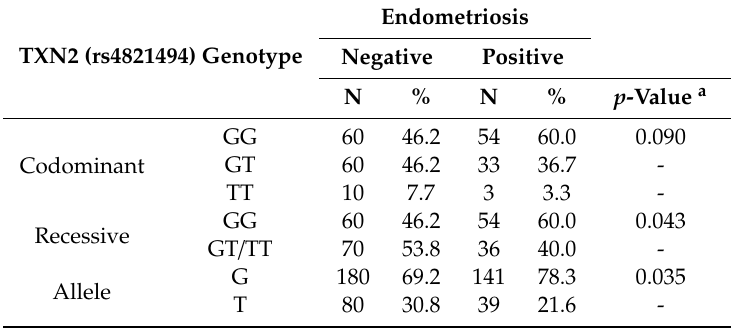
Table 3. Frequencies of TXN2 (rs4821494) polymorphism among women with or without endometriosis.